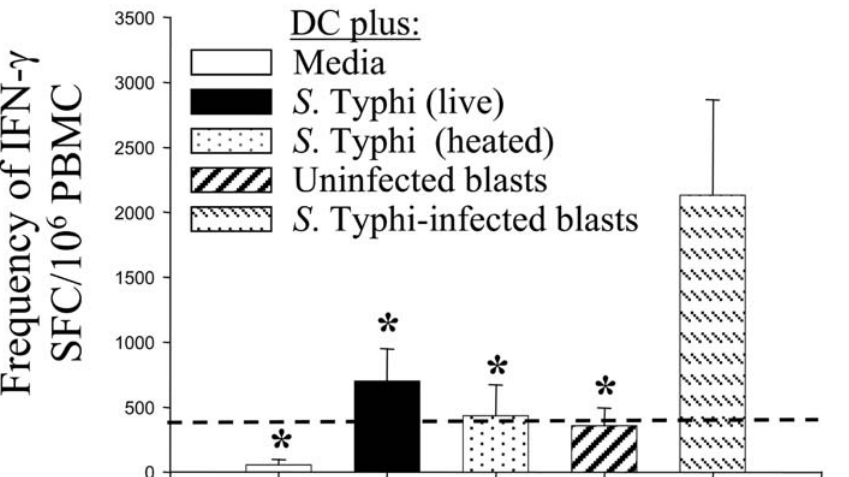
Figure 10. Cross-priming DC are the most effective stimulus in promoting the expansion of S. Typhi-specific T cells. Net frequencies of IFN- c -spot forming cells (SFC) were assessed by an IFN- c ELISPOT assay using in vitro expanded PBMC as effectors and autologous blasts infected with live S. Typhi as stimulators. PBMC were co-cultured with their own DC alone or DC that had been pulsed with live or heat-killed S. Typhi, or uninfected or S. Typhi-infected autologous blasts at a 1:4 blast:DC ratio. Net frequencies of IFN- c SFC were calculated as described in Materials and Methods. The dashed line represents the cut-off for positive-ELISPOT assays determined as described in Materials and Methods. Bar graphs show means + SE of 3 experiments using 4 different donors (*, p , 0.05 compared with DC pulsed with S. Typhi-infected